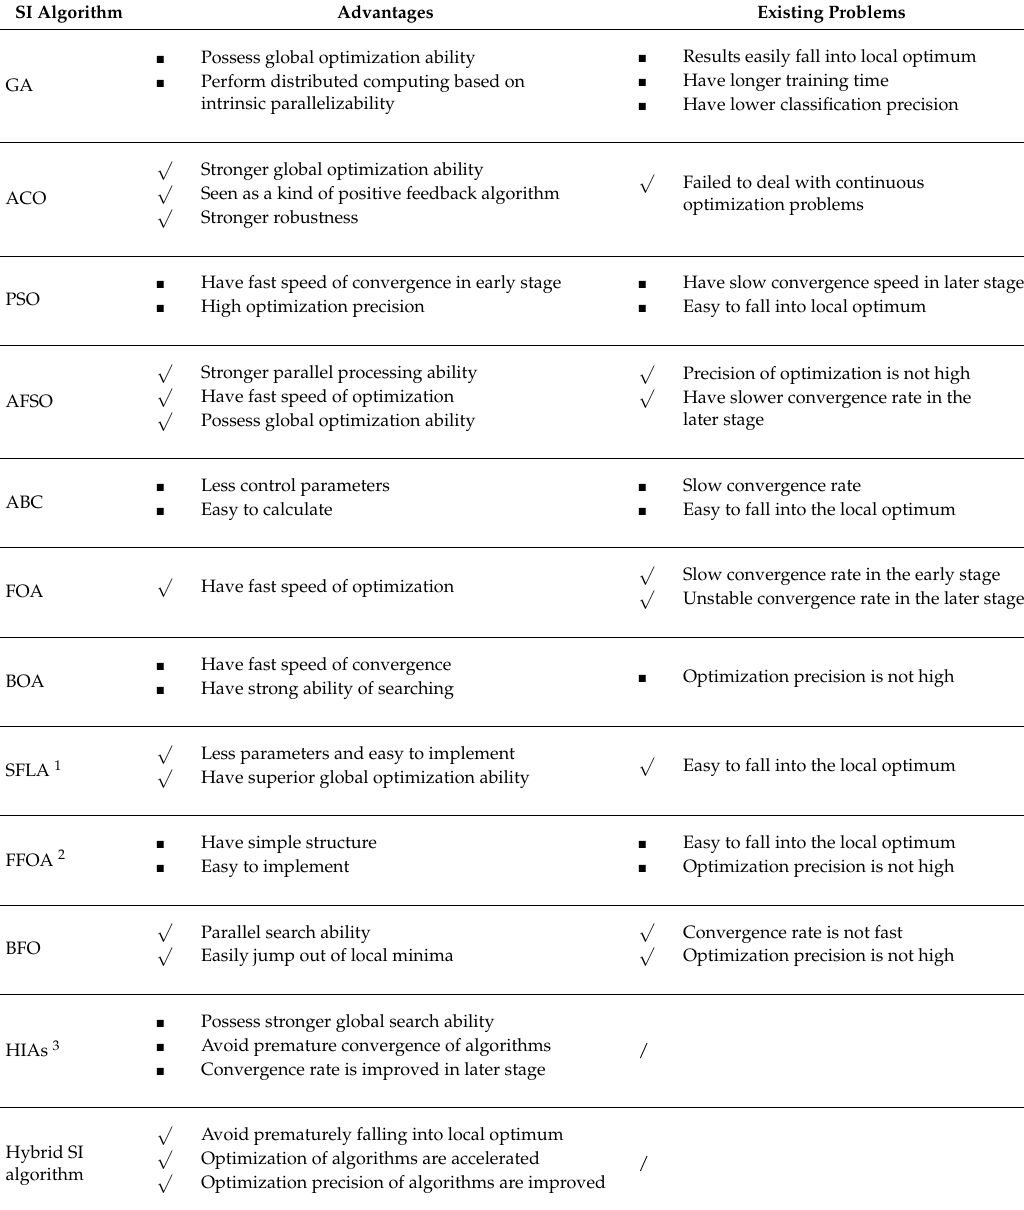
Table 10. A detailed comparison of advantages and disadvantages of optimizing the SVM parameters of various SI algorithms in